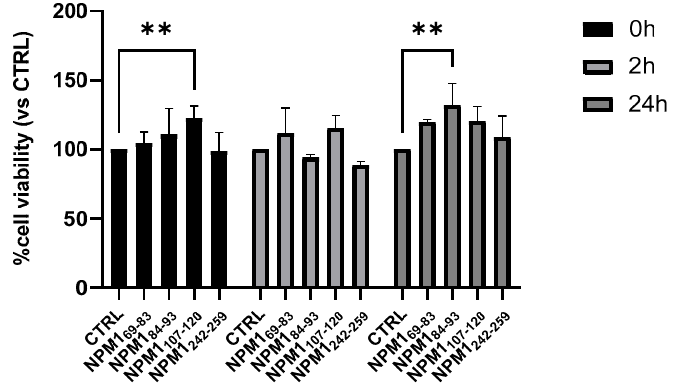
Figure 8. Cell viability effects of NPM1 fragment. The histogram reports the percent of cell viability (100% viable cells represent the control, CTRL) treated with peptides pre-incubated at three different times: 0, 2 and 24 h. The histogram is representative of a single experiment performed in triplicate. Results are expressed as mean ± SD. The statistical analyses were performed with the GraphPad Prism 9 software using two-way ANOVA corrected for multiple comparison by the Dunnet test (** p < 0.005).